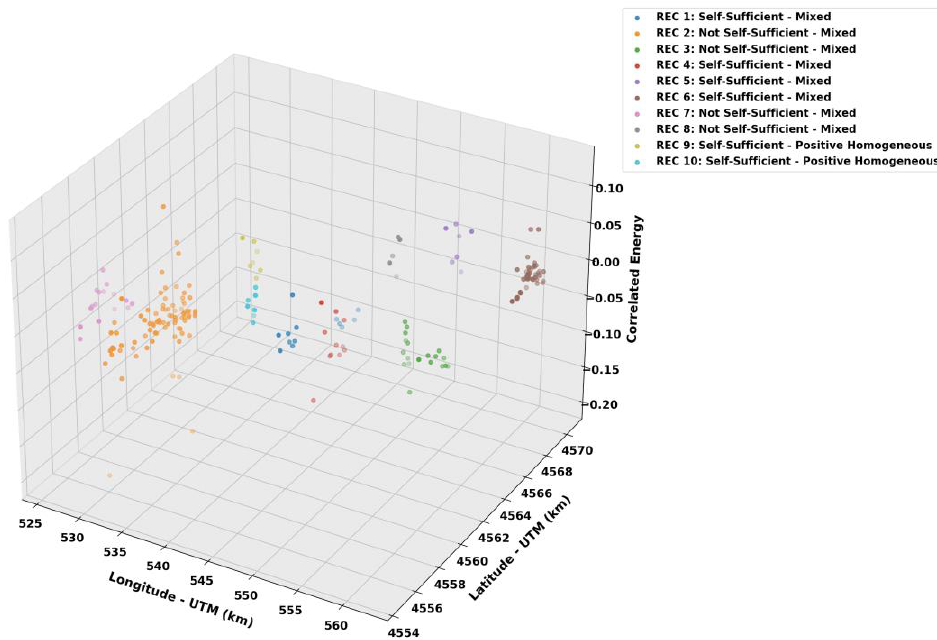
Figure 20. Members distributed by REC — average-link.